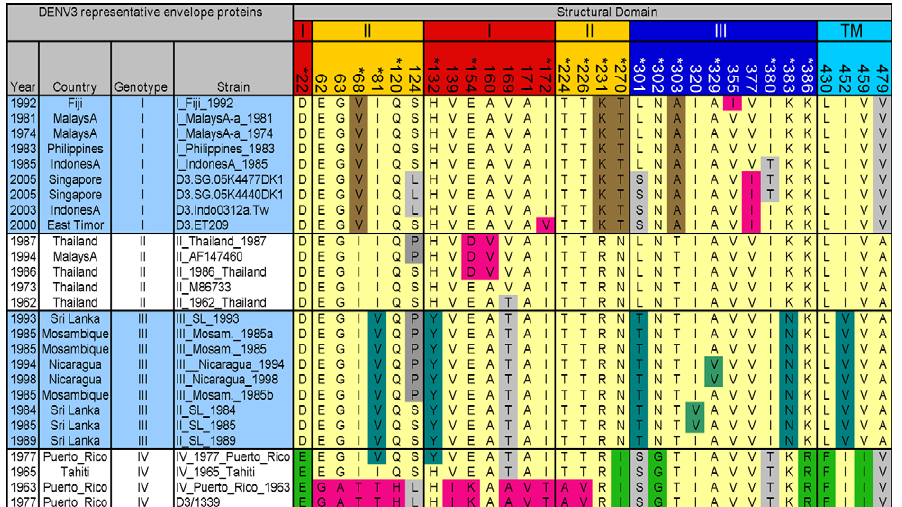
Figure 1. Informative sites in the envelope protein of dengue serotype 3. One hundred and seventy five DENV3 envelope protein sequences were aligned and 32 informative/variable sites were identified. The figure displays the informative sites and the variability within and between the different genotypes (I, II, III and IV) of DENV3 [26]. The envelope protein is divided into four domains indicated by the coloring on the position numbers. Red, domain I; yellow, domain II; blue, domain III; and cyan, transmembrane domain (TM). Residues that are unique to a given genotype are indicated by unique colors. Brown, genotype I; teal, genotype III; green, genotype IV; pink, unique polymorphisms; light yellow, predominant residues shared among multiple genotypes; and gray, variation shared among multiple